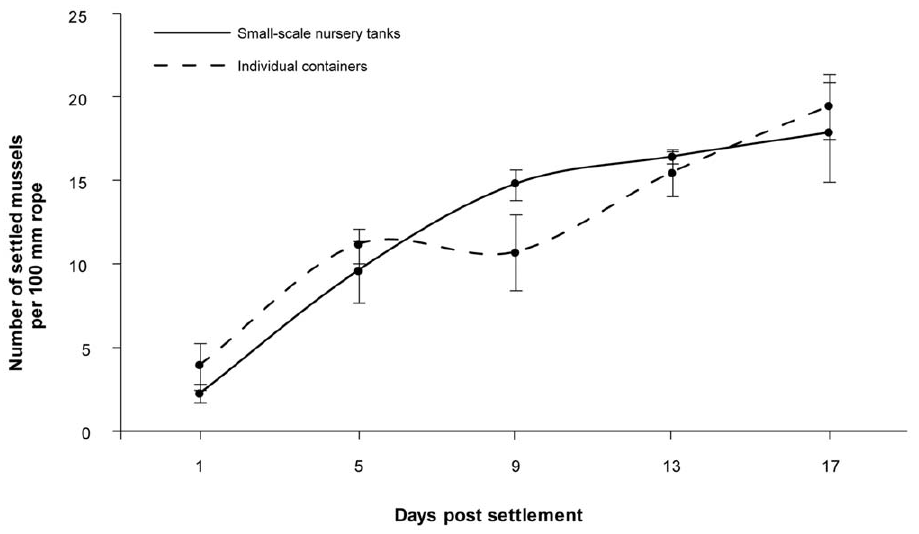
Figure 4. Settlement on the outside of ropes. Mean number of settled mussels on 100 mm long rope samples maintained in small-scale nursery tanks (solid line) and individual containers (dashed line) over time (1 to 17 days post settlement, which correspond to 23 to 39 days post fertilisation). Means 6 SE are shown ( n =3).